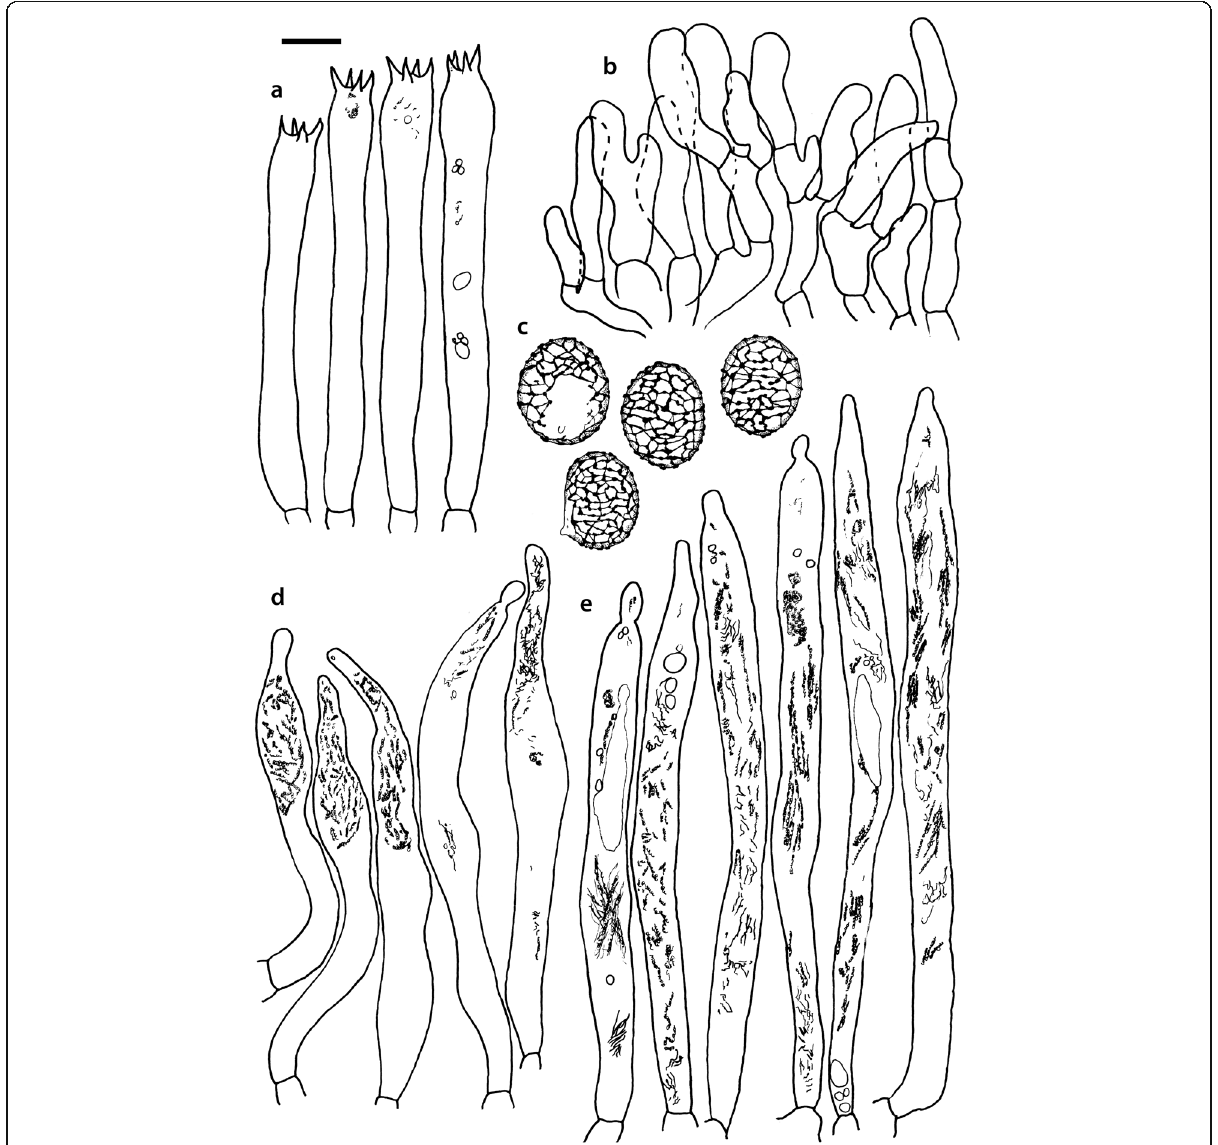
Fig. 14 Russula ustulata (AV 16 – 019), hymenium. a Basidia. b Marginal cells. c Basidiospores. d Cystidia near lamellae edges. e Cystidia on lamellae sides. Bar =10 μ m, except for c 5 μ